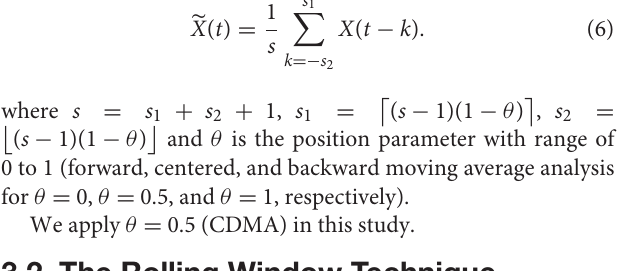
Frontiers in Physics |